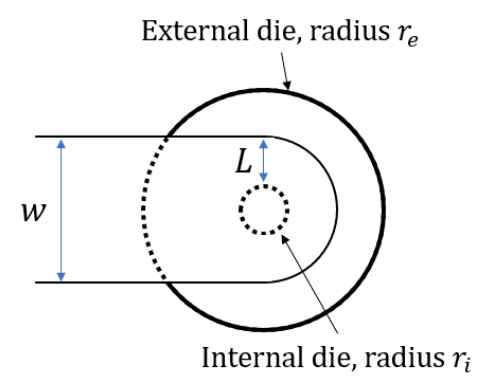
Figure 5. Bottom view of an extruder with a spreading head. The extrudate flows from the nozzle with radius r i , while r e is the radius of the spreading head. L denotes how much the extrudate expands on the y axis during the printing with respect to the internal die, and w is the total width of the